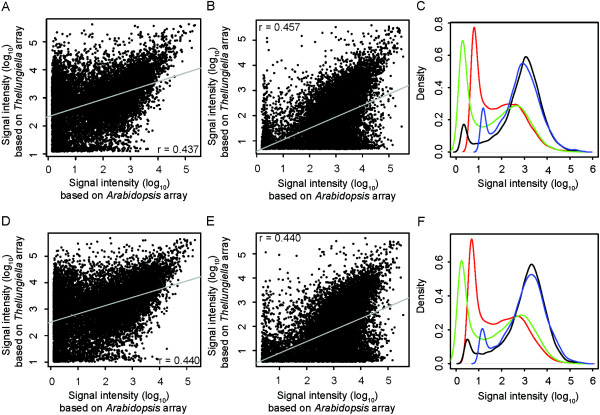
Comparison of median raw signal intensities of 15,557 genes matched between T. salsuginea and Arabidopsis arrays.T. salsuginea genes were matched with A. thaliana genes using BLASTX, with a significance cut-off of E < 10-10 for a sequence similarity search against the Arabidopsis TAIR10 database. This resulted in 15,557 genes that matched between the two microarrays. Pearson’ s correlations (p < 2.2 × 10-16) are shown between log10-transformed signal intensities obtained from T. salsuginea and Arabidopsis arrays hybridized with identical leaf RNA samples from either non-acclimated Yukon (A) or Col-0 (B), or cold acclimated Yukon (D) or Col-0 (E). The median density signal distributions of all 15,557 probes after hybridization with non-acclimated (C) or cold acclimated RNA samples (F) are also shown. The green lines indicate the density distribution of median signal intensity of Yukon samples hybridized on the array designed for Arabidopsis, while the blue lines show the density distribution of Yukon samples hybridized on the array designed for T. salsuginea. The red lines show the density distribution of Col-0 samples hybridized on the Agilent array designed for T. salsuginea and the black lines show the density distribution of Col-0 samples hybridized on the array designed for Arabidopsis.